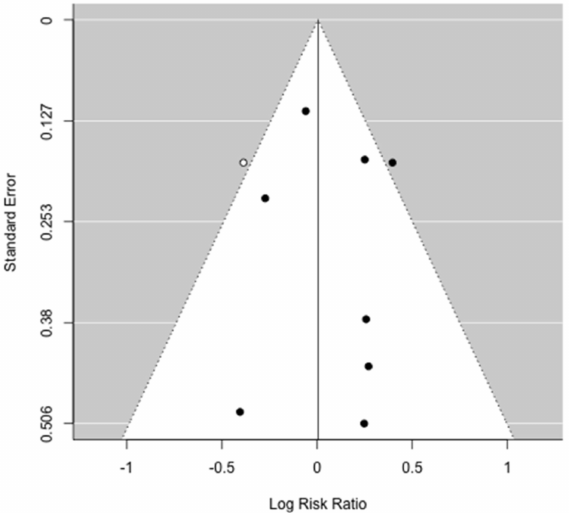
Figure 3. Funnel plot for the prevalence ratio of major complications after pancreatic resection. Black circles identified studies included in the meta-analysis. Publication bias analysis estimated one study missing (white